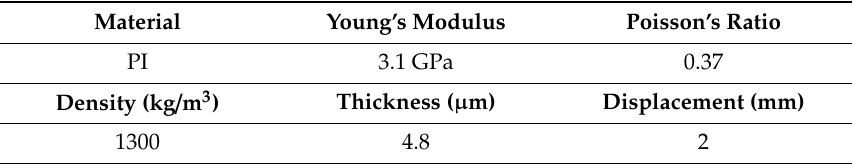
Figure 4. Simulation of mechanical tensile properties of the flexible interconnection. ( a ) The relationship between the stress and displacement. ( b ) The change in the shape of the flexible interconnection. ( c ) The distribution of internal stresses in the interconnection. Table 1. Parameters used in simulation.